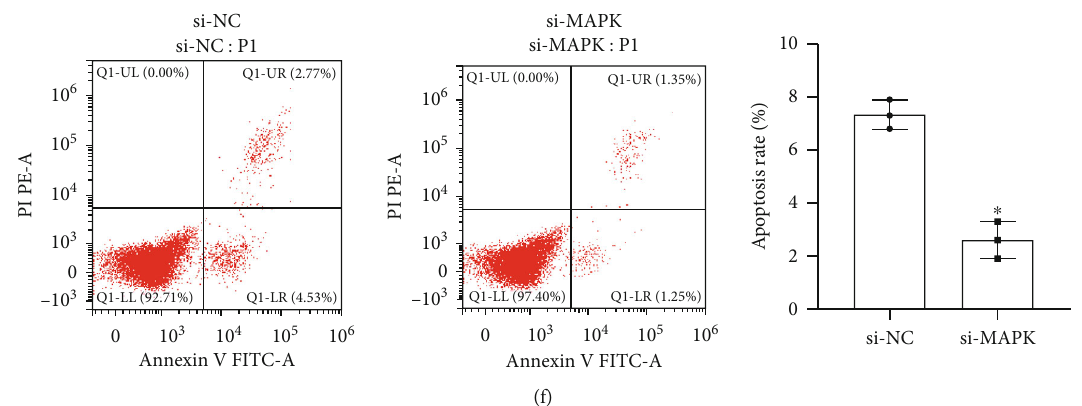
Figure 5: Inhibition of the MAPK signaling pathway to regulate astrocytes. (a) qRT-PCR detected p38 expression. (b) ELISA to measure the contents of IFN- γ , IL-1 β , IL-6, and TGF- β 1. (c) qRT-PCR examined the expression of iNOS. (d) Western Blot examined the protein expression of iNOS. (e) Immuno fl uorescence detection of occludin, claudin 3, and ZO-1 fl uorescence intensity (scale bar, 100 μ m). (f) Flow cytometry was used to measure the apoptosis rate of astrocytes. ∗ Compared with the si-NC group, P < 0 : 05 . The above experimental results were all measurement data. Data are expressed as the mean ± SD . The unpaired t -test was used between the two